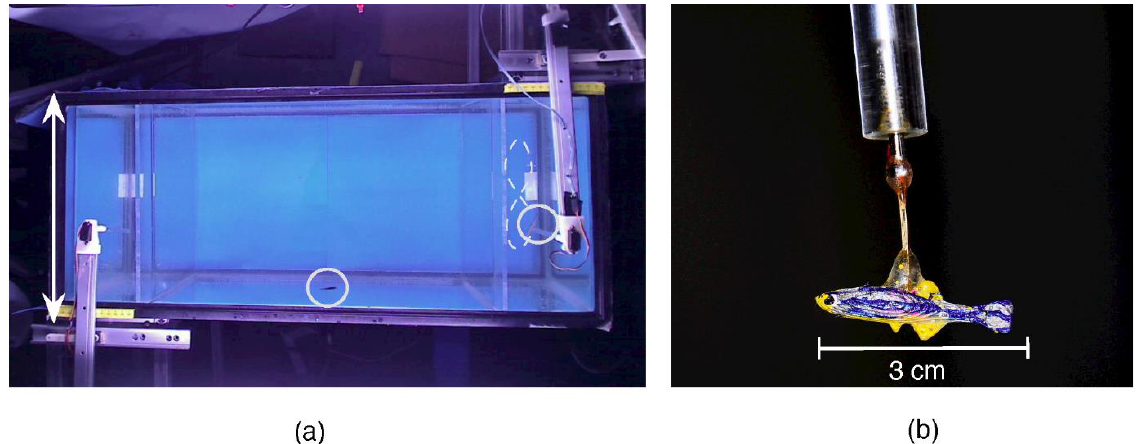
Figure 3 . Experimental setup for ethorobotics experiments on zebrafish social behavior. (a) Top view of the tripartitioned tank with two robotic platforms on each side. The fish in the central compartment and the replica in the right compartment are circled. The dashed curve is the figure-eight that is travelled by the replica and the bidirectional arrow labels the vertical axis that is used for the transfer entropy analysis. (b) 3-D printed painted replica of the zebrafish that is attached to the support rod. [Reproduced from (Butail et al.,